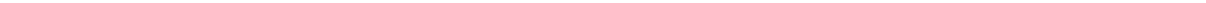
Fig. 3 Lymphatic vascular hyperplasia in Vegfr3 -deleted ears is driven by VEGF-C signaling. a Quanti fi cation of blunt-ended vessels (lymphatic capillaries) in 5 weeks old mice treated with Tamoxifen at P2, P4, and P6. Central region excludes 560 μ m area (tip) from the edge of the ear. Bars represent mean ( n = 3 – 6 mice, as indicated) ± s.e.m. b Whole-mount immuno fl uorescence of Vegfr3 fl ox/ fl ox ; R26-mTmG;Prox1-CreER T2 ear skin showing vessel interconnections (arrows) formed of non-targeted (GFP − ) LYVE1 + (left) and VEGFR3 + (right) LECs. c Whole-mount immuno fl uorescence of ear skin of 3 weeks old Vegfr3 fl ox/ fl ox ; R26-mTmG;Prox1-CreER T2 and Cre-negative littermate mice treated with Tamoxifen at P2, P4, and P6, and inhibitors of VEGF-C signaling (the VEGF-C-trap VEGFR3-Ig, the VEGFR3 inhibitor MAZ51, or the VEGFR2 blocking antibody DC101). Quanti fi cation of ( d ) vessel area and ( e ) branch points. Bars represent mean ( n = 3 (untreated groups) or n = 4 (treated groups) mice) ± s.e.m. f – h Visualization by whole-mount immuno fl uorescence (arrows in f ) and quanti fi cation of blunt-ended vessels in the ( g ) entire and ( h ) central region of the ear in Vegfr3 fl ox/ fl ox ; R26-mTmG;Prox1-CreER T2 mice treated with the VEGFR3 kinase inhibitor MAZ51. In g , h , bars represent mean ( n = 3 (untreated) or n = 4 (MAZ51, DC101) mice) ± s.e.m. * P < 0.05, ** P < 0.01, *** P < 0.001, **** P < 0.0001. Two-tailed unpaired Student ’ s t test ( a , d , e , h ). Scale bars: 200 µ m ( b , c , f ). ns: not signi fi